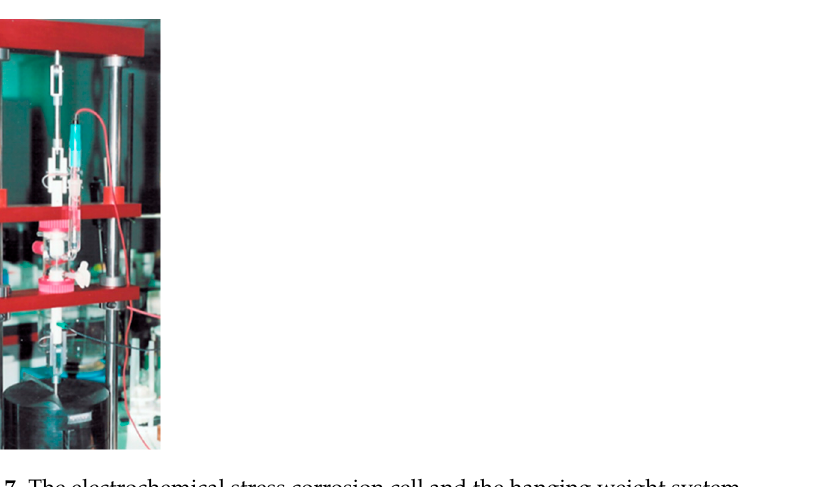
Figure 6. The electrochemical stress corrosion cell.